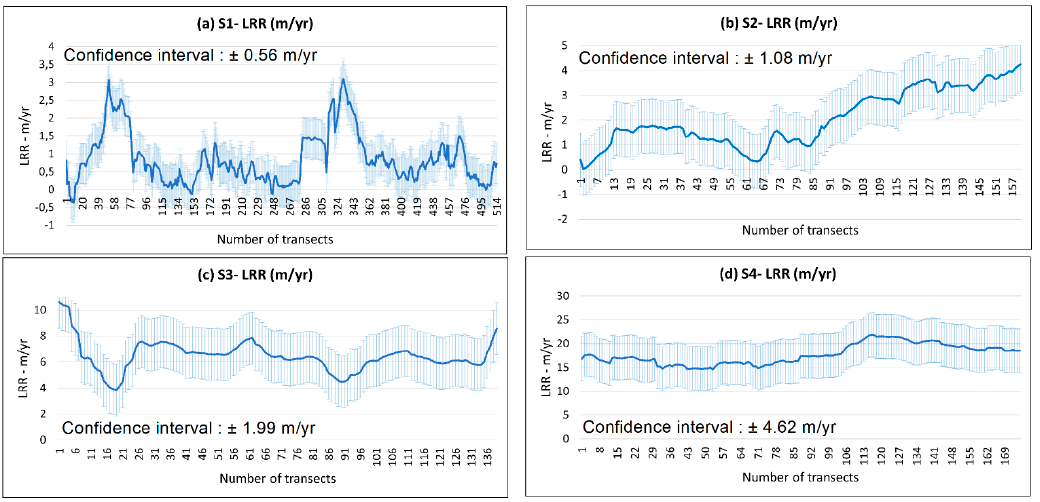
Figure 11. LRR values in each section in conjunction with the confidence band (LCI90%). ( a ) S1 section with LCI90% of ±0.56 m/year, ( b ) S2 section with LCI90% of ±1.08 m/year, ( c ) S3 section with LCI90% of ±1.99 m/year, and ( d ) S4 section with LCI90% of ±4.62 m/year.